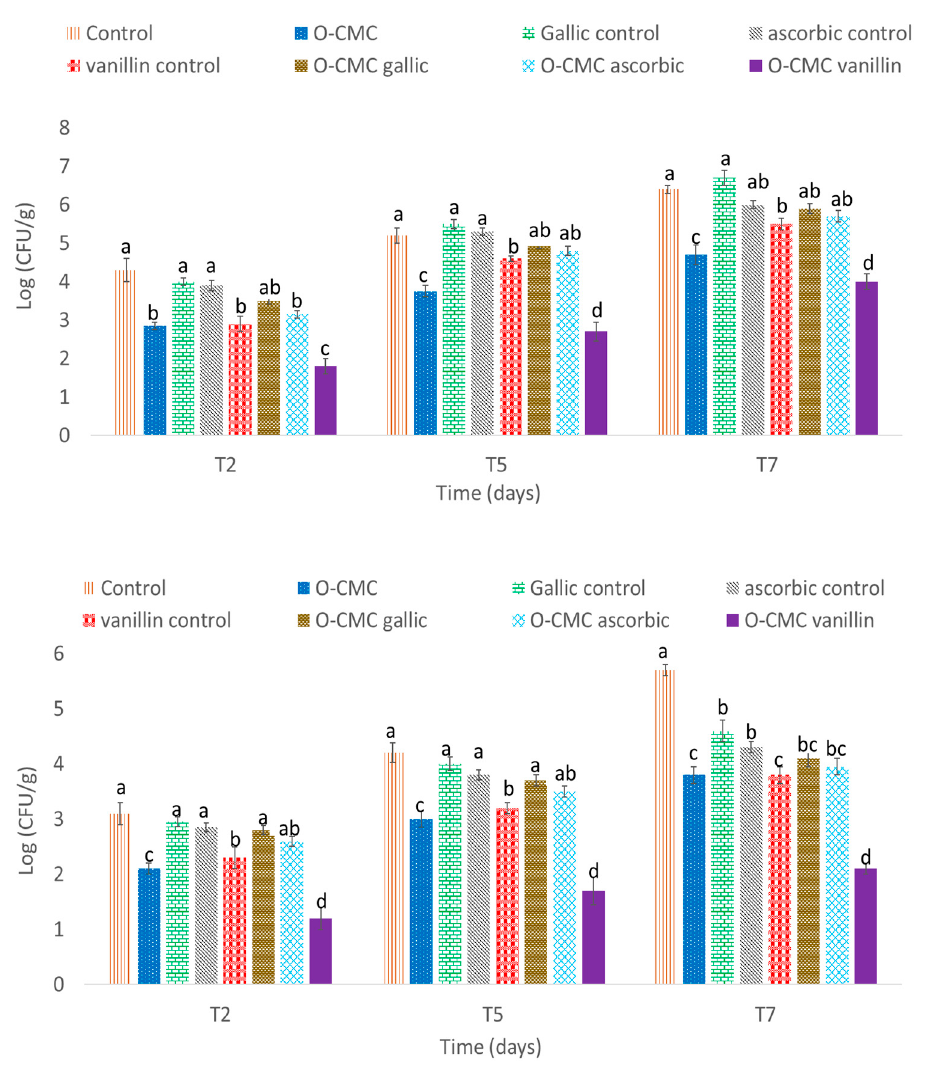
Figure 6. ( up ) Total microbial count on PCA plates and ( down ) mold/yeast count on PDA + A plates of fresh-cut melon after 2nd, 5th, and 7th day of storage at 4 ◦ C treated with oligo-CMC formulations. Values marked by a different letter within the same sampling time are significantly different according to Tukey HSD test at p ≤ 0.05.